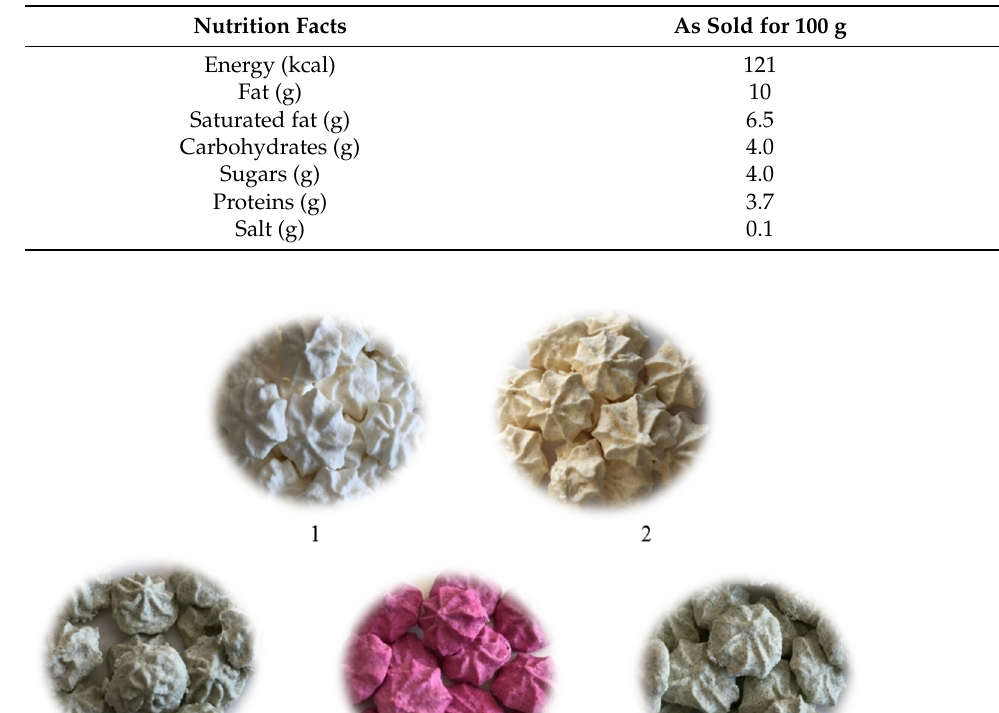
Table 2. Nutrition facts of Greek-style yogurt.